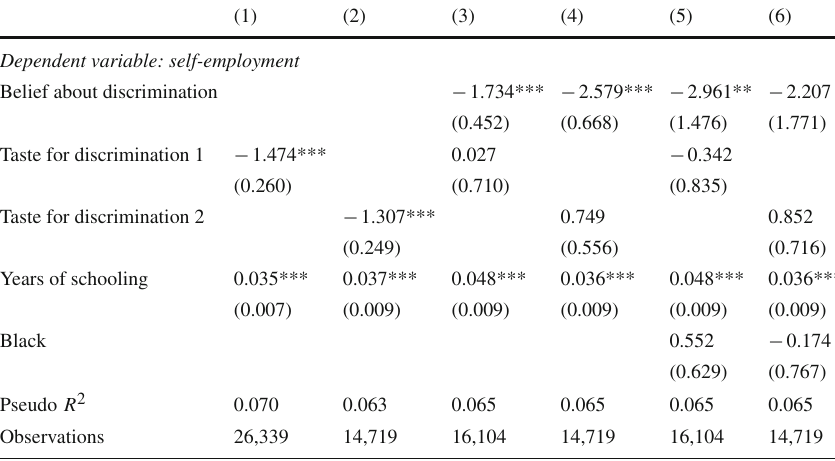
Table 2 Baseline logistic regression. Source : General Social